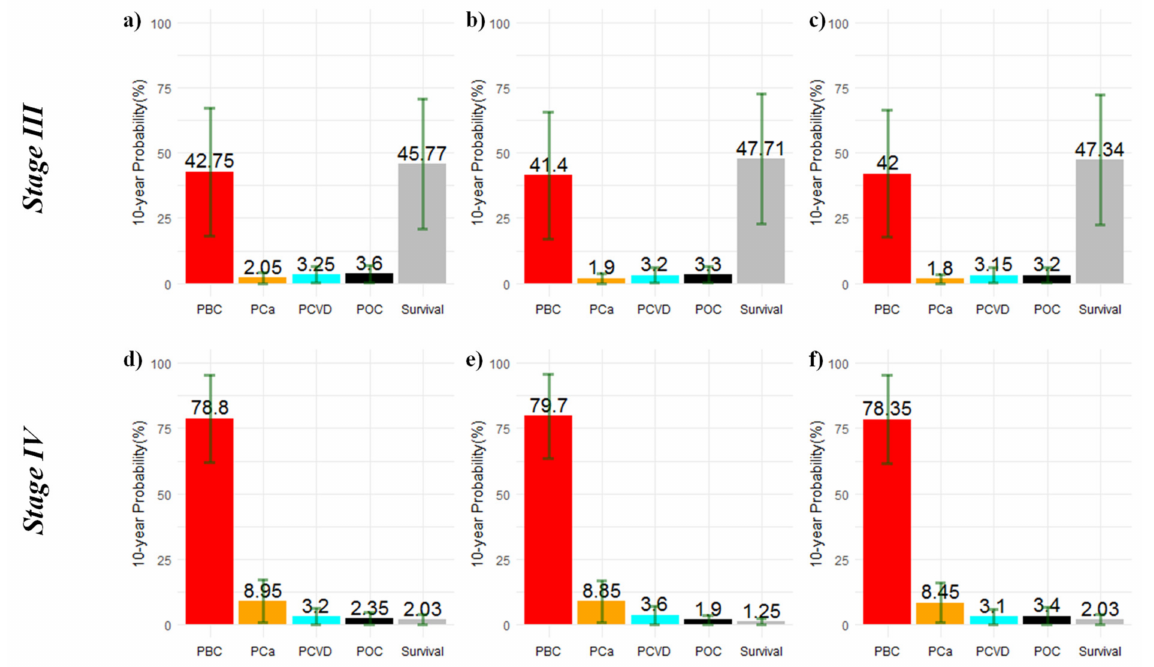
Figure 2. Cause-specific 10-year cumulative probabilities of death and probability of survival beyond 10 years after breast cancer diagnosis in Stages III–IV. Panels show the results stratified by age group for the whole cohort: ≤ 49 ( a , d ), 50–68 ( b , e ), and ≥ 69 years ( c , f ). Note: vertical lines in dark green represent the standard deviation of the probability estimates. Table 3. Relative risks derived from the all-cause mortality and the cause-specific modelling analysis. Cox Modelling